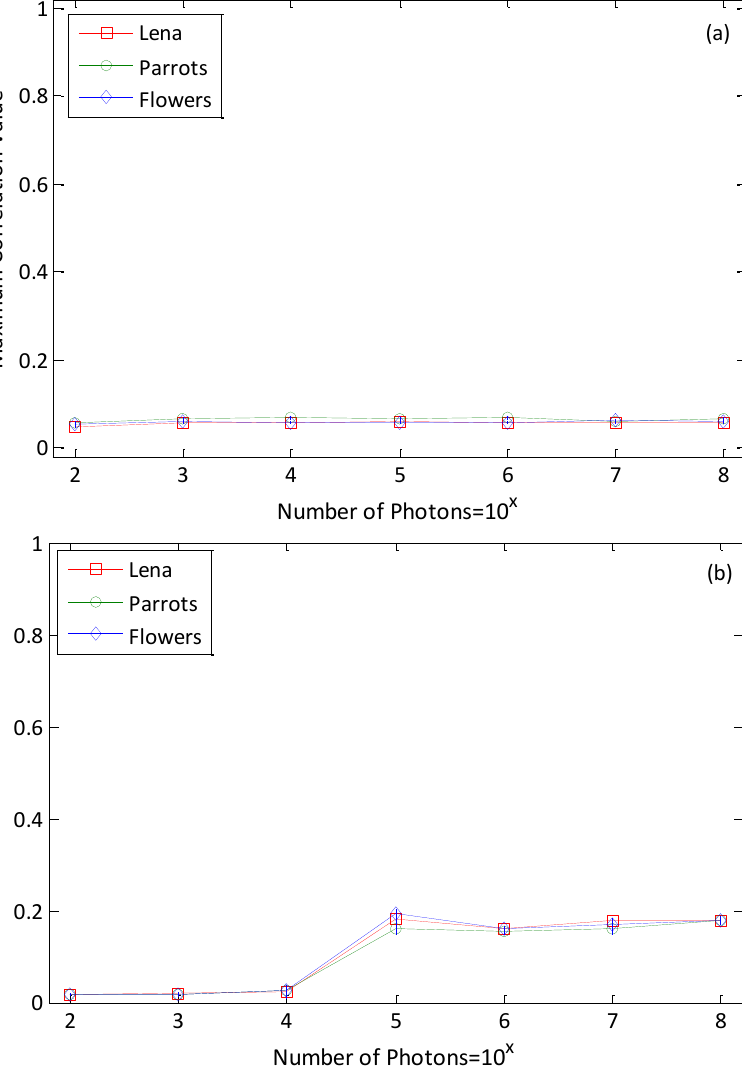
Figure 10. ( a ) The maximum nonlinear cross-correlation values between reference Bayer and decrypted false class Bayer images; ( b ) The maximum nonlinear cross-correlation values between reference and decrypted false class multispectral images. (Error bars represent ±1 standard deviation of the 50 times measurement, k =